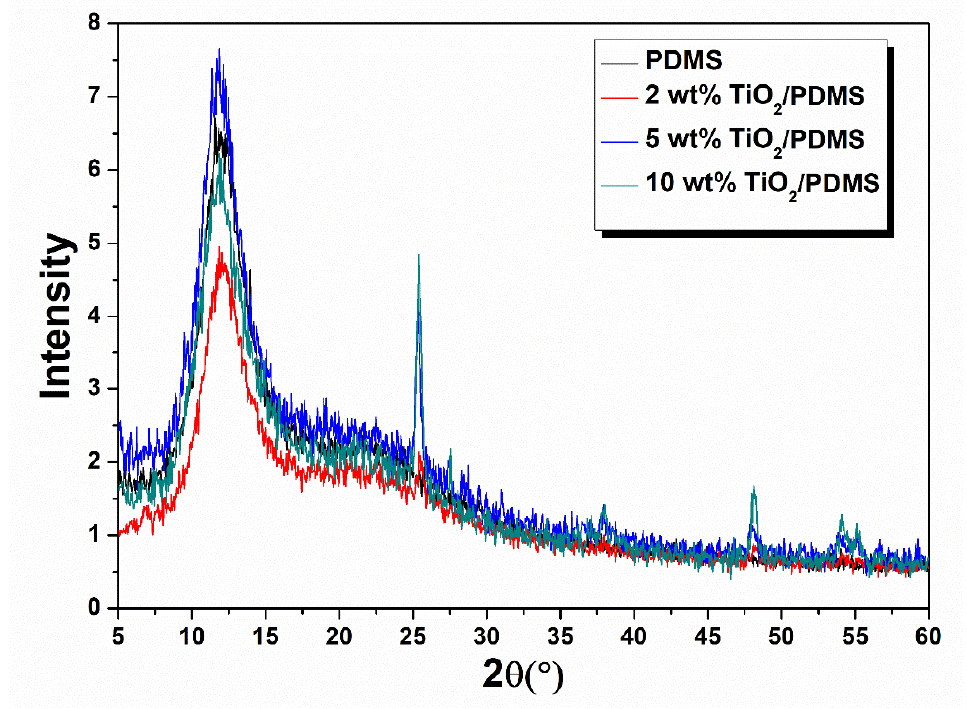
Figure 1. XRD spectra of PDMS and TiO 2 /PDMS nanocomposites.